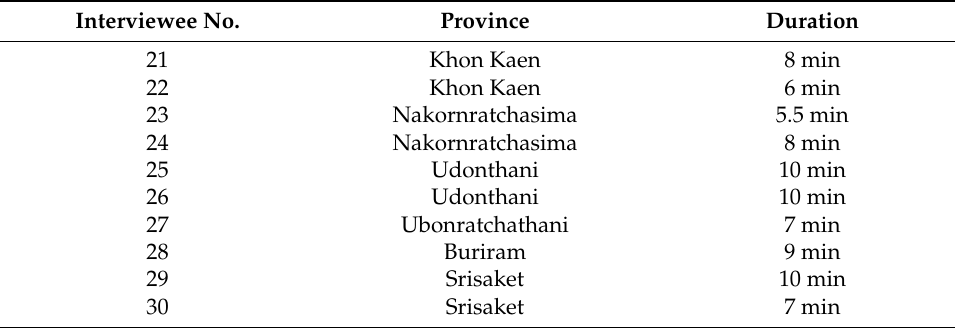
Table A3. Interviews and Interviewees of Thai Participants: Segment 3. Interviewee